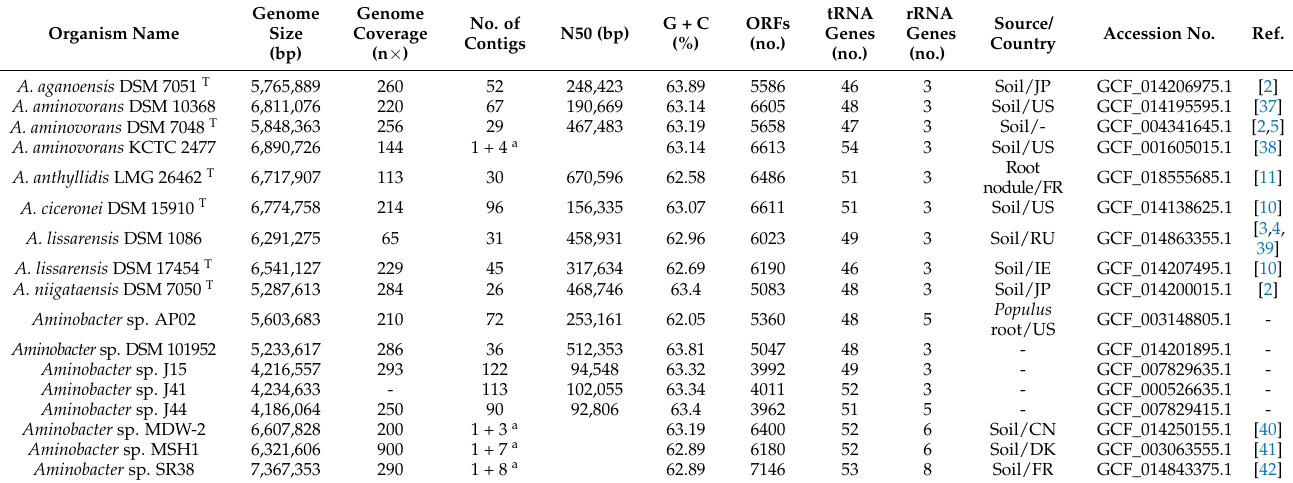
Table 1. Genome sequence features of selected Aminobacter